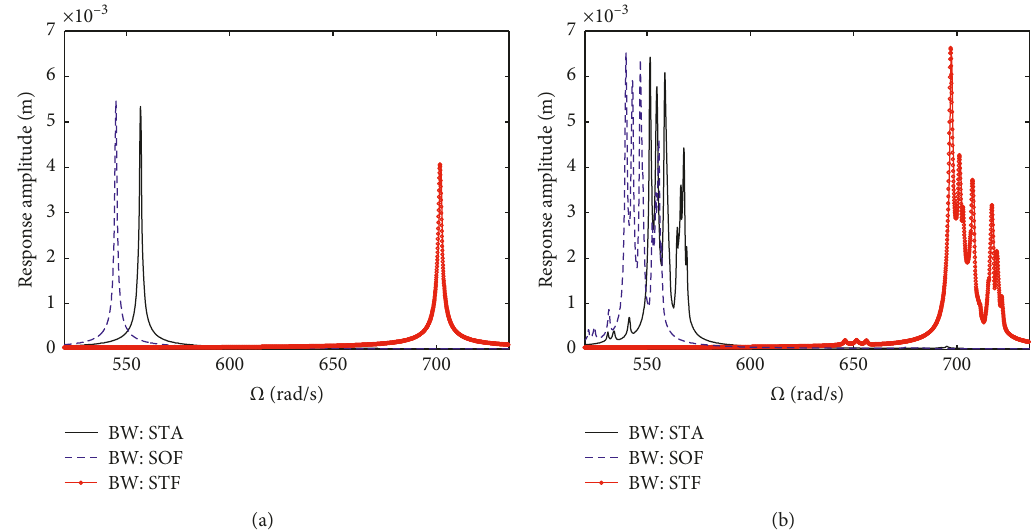
Figure 11: Forced response of tuned and mistuned bladed disk excited by backward traveling wave excitations of 3EO: (a) tuned case and (b) mistuned